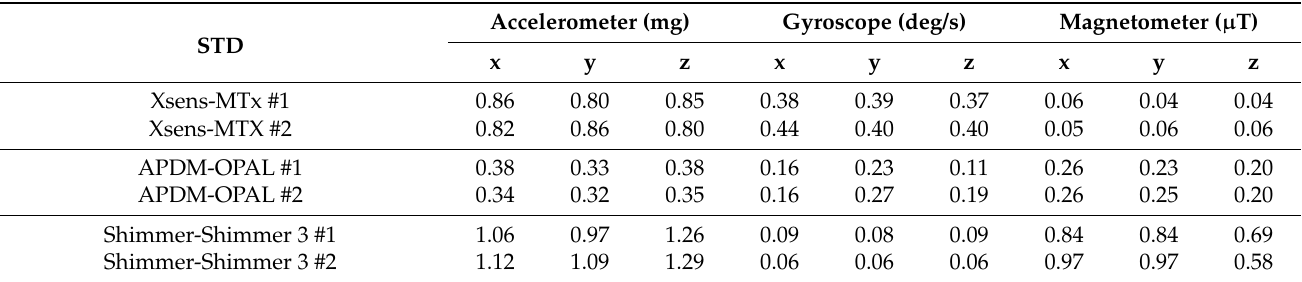
Table 3. The STD of the three sensors computed for each of the six MIMUs during one minute of static acquisition. Taken from [10].